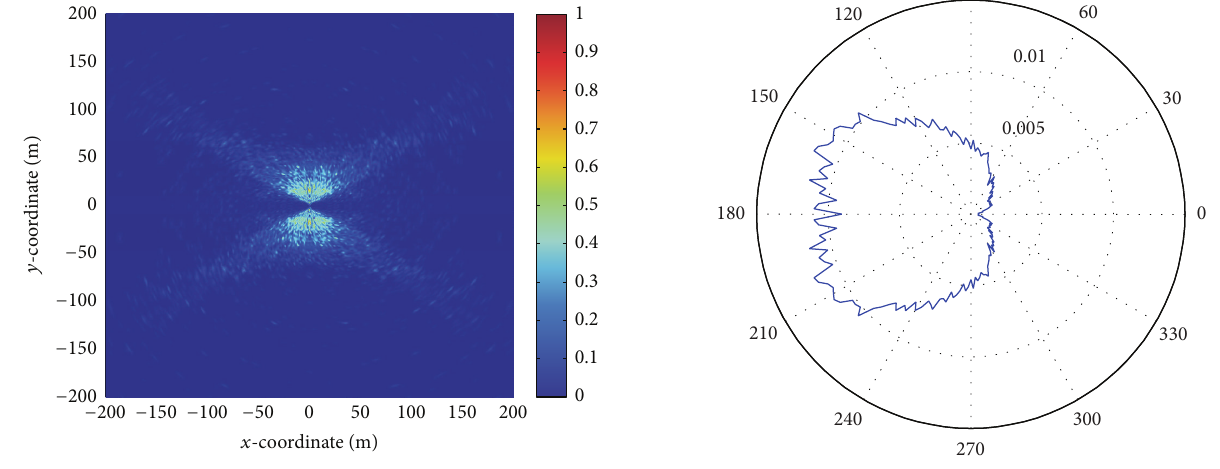
Figure 13: Discrete probability density function of the relative satellite-reflector azimuth angle 𝛼 in the urban city center environ- ment at 30 ∘ elevation.